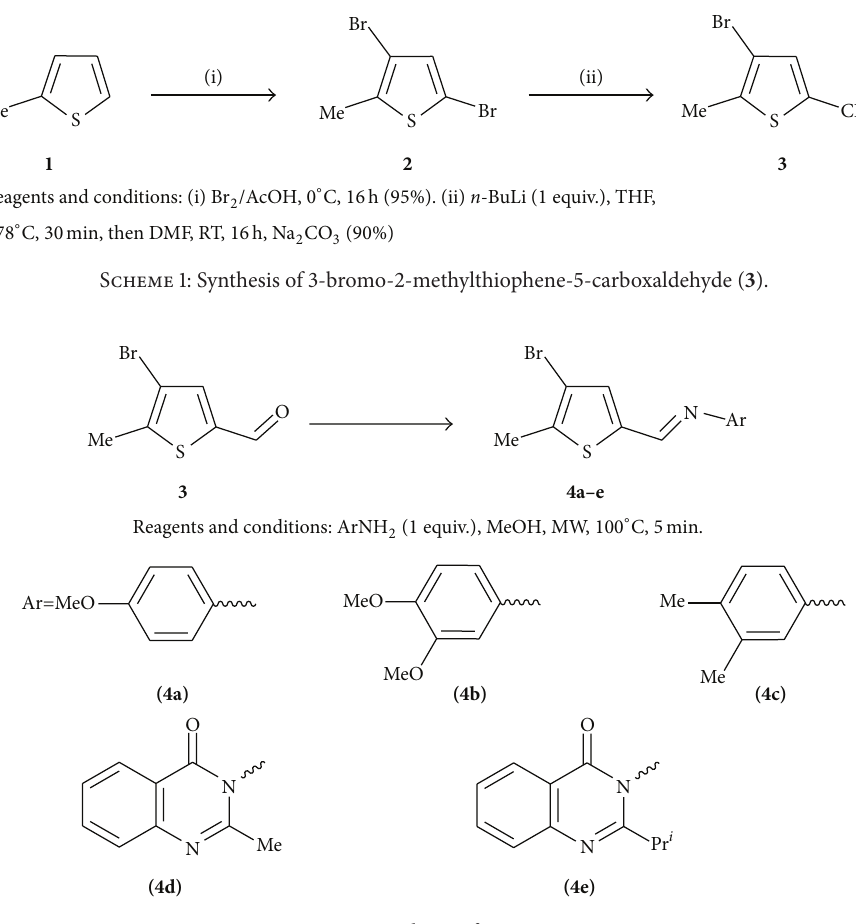
Scheme 2: Synthesis of imines 4a–e